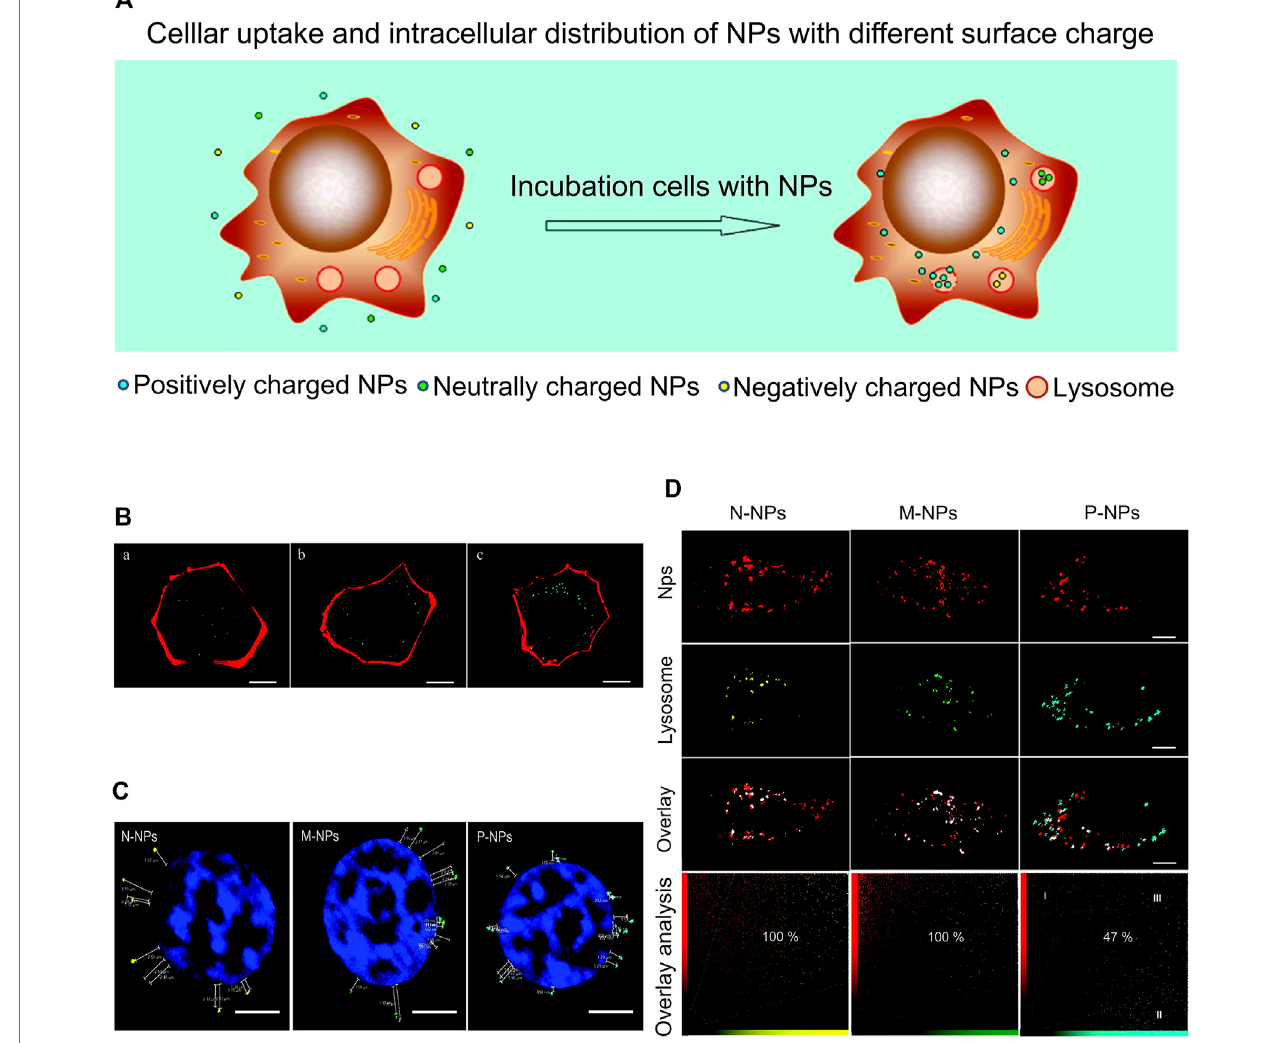
FIGURE2 | Surfacecharges affect cellular uptake. (A) Cellular uptake and intracellular distribution of NPswith different surface charges. (B) CLSM images ofHKC cells incubated with NPs of different charges: (A) negatively charged, (B) neutrally charged, and (C) positively charged. (C) CLSM images of HKC cells after treatment with NPs of different charges. (D) CLSM images of lysosomes of HKC cells treated with different nanoparticles for 6 h. Reproduced with permission from (Yue et al., 2011).